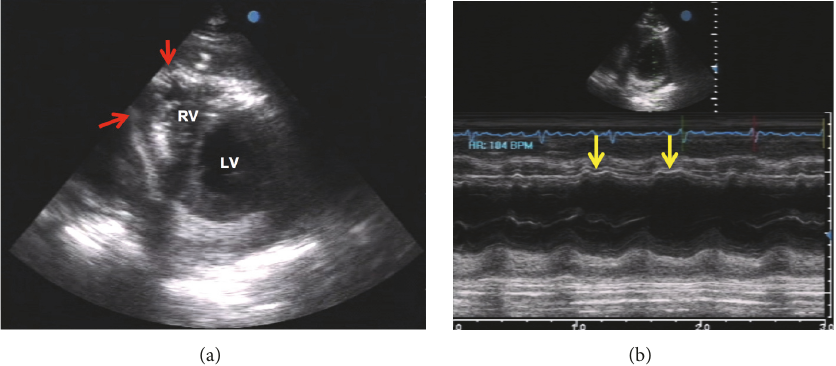
Figure 4: Echocardiographic parasternal short axis views at the level of the mid-left ventricle (LV). (a) The free wall of the right ventricle (RV) appears adherent to the adjacent pericardium (red arrows). There was note of septal bounce, leading to a D-shaped LV cavity during diastole. (b) M-mode of the same view confirmed the wavy motion (yellow arrows) of the interventricular septum representing septal bounce.